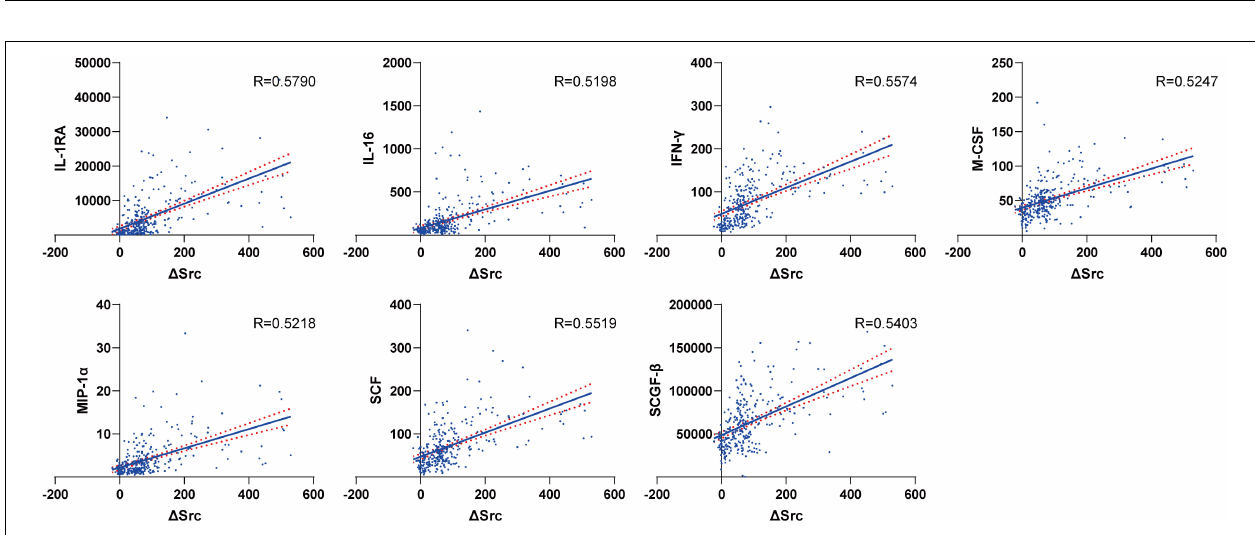
FIGURE 6 | The most significantly correlated plasma cytokines with the postoperative (cid:49) SCr.